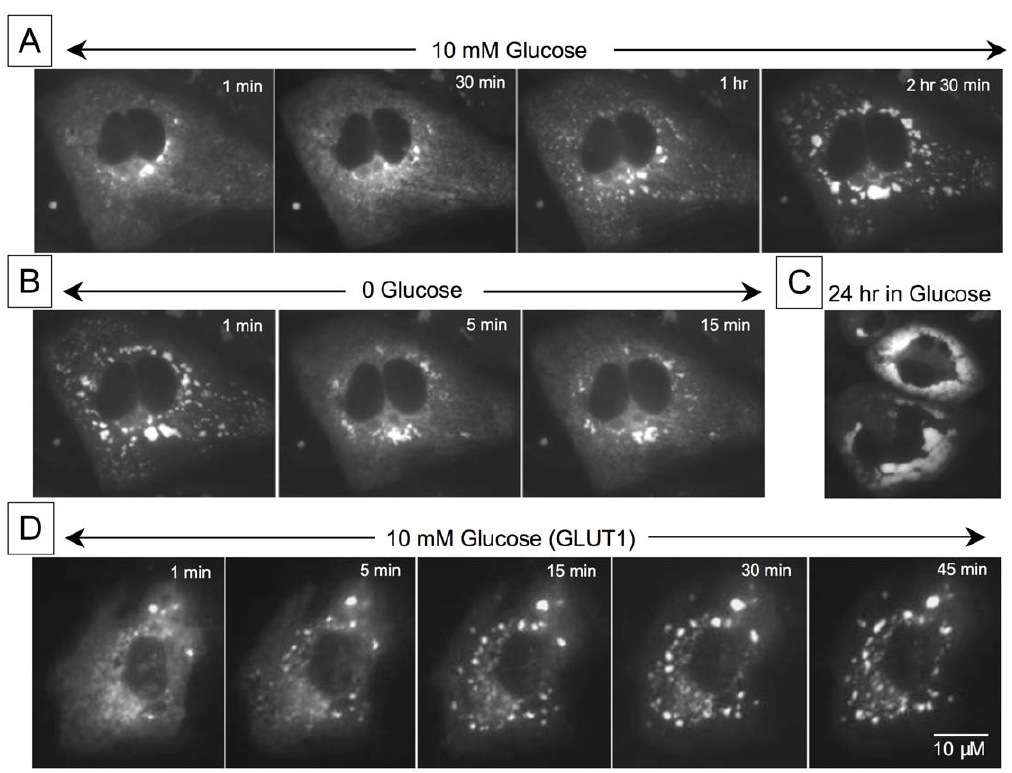
Figure 4. Effects of GLUT1 overexpression on glycogen synthesis and breakdown in CHO cells. The rate of glycogen formation without (A) and with (D) overexpression of GLUT1 and the rate of glycogen degradation (B) was studied using a protein targeted to glycogen linked to YFP (PTG-YFP). In Panel A and D the cells were incubated in the absence of glucose for 2 to 3 hours prior to beginning cell imaging. This incubation in the absence of glucose was carried out to deplete preformed glycogen. Without GLUT1 overexpression glycogen build up was slow, occurring over several hours. This build up proceeded for up to 24 h filling almost completely the cell in some cases (C). With GLUT1 overexpression the rate of glycogen synthesis increased and glycogen deposits could be observed 5 min after exposure to 10 mM glucose outside. It is interesting to note that glycogen deposition occurred at least initially near the nucleus where mitochondria aggregate, suggesting that G-6-P generated by glycogen degradation may be directly fed on to